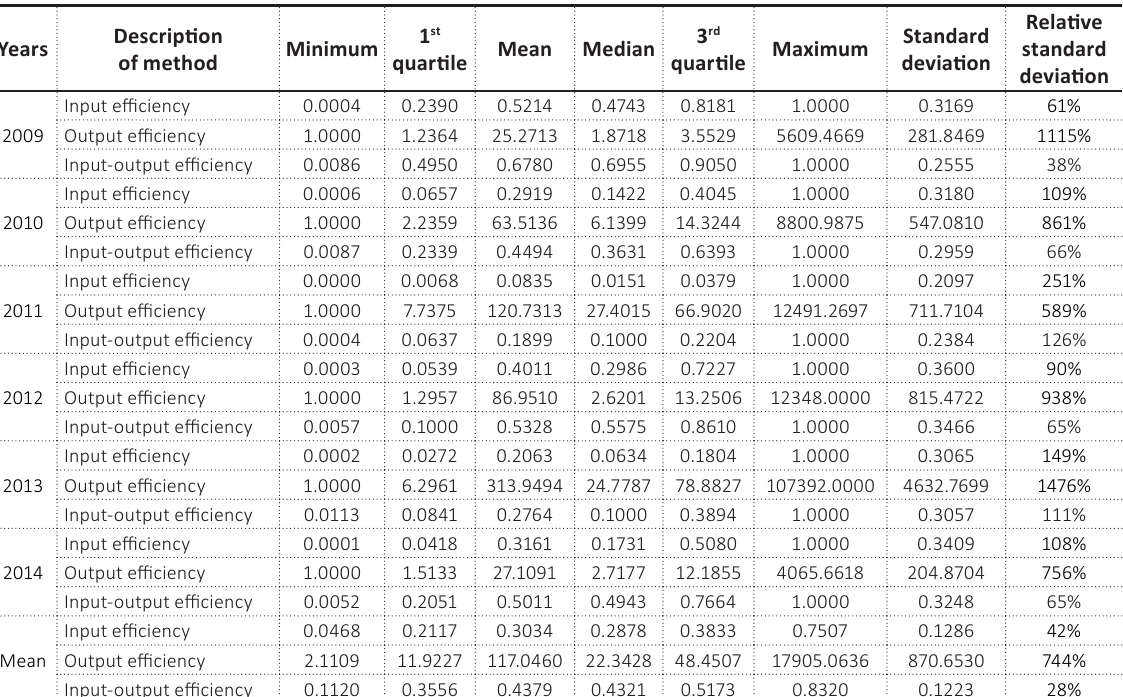
Table 1. Main statistical characteristics of the efficiency analysis of the Northern Great Plain region’s food trading